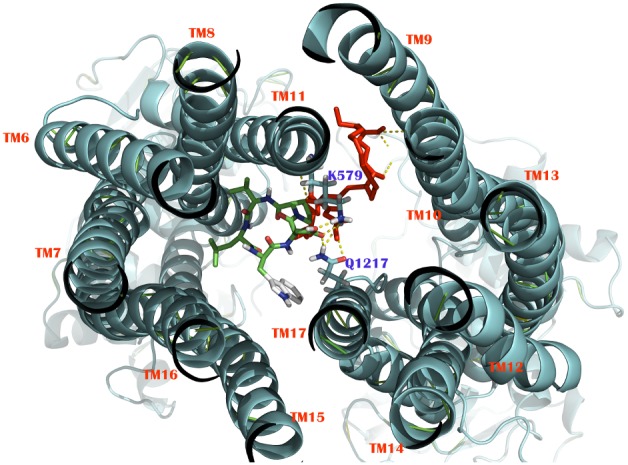
Extracellular face view of an arrangement of transmembrane (TM) regions at the proposed binding sites.Docking poses of substrate BQ-123 (green) and leukotriene C4 (red) into two different predicted substrate binding sites in the human open conformation ABCC6 homology model overlap partially with each other, sharing common residues Lys579 and Gln1217 by forming hydrogen bonding. The 12 transmembrane domains are numbered TM6 to TM17 (red).